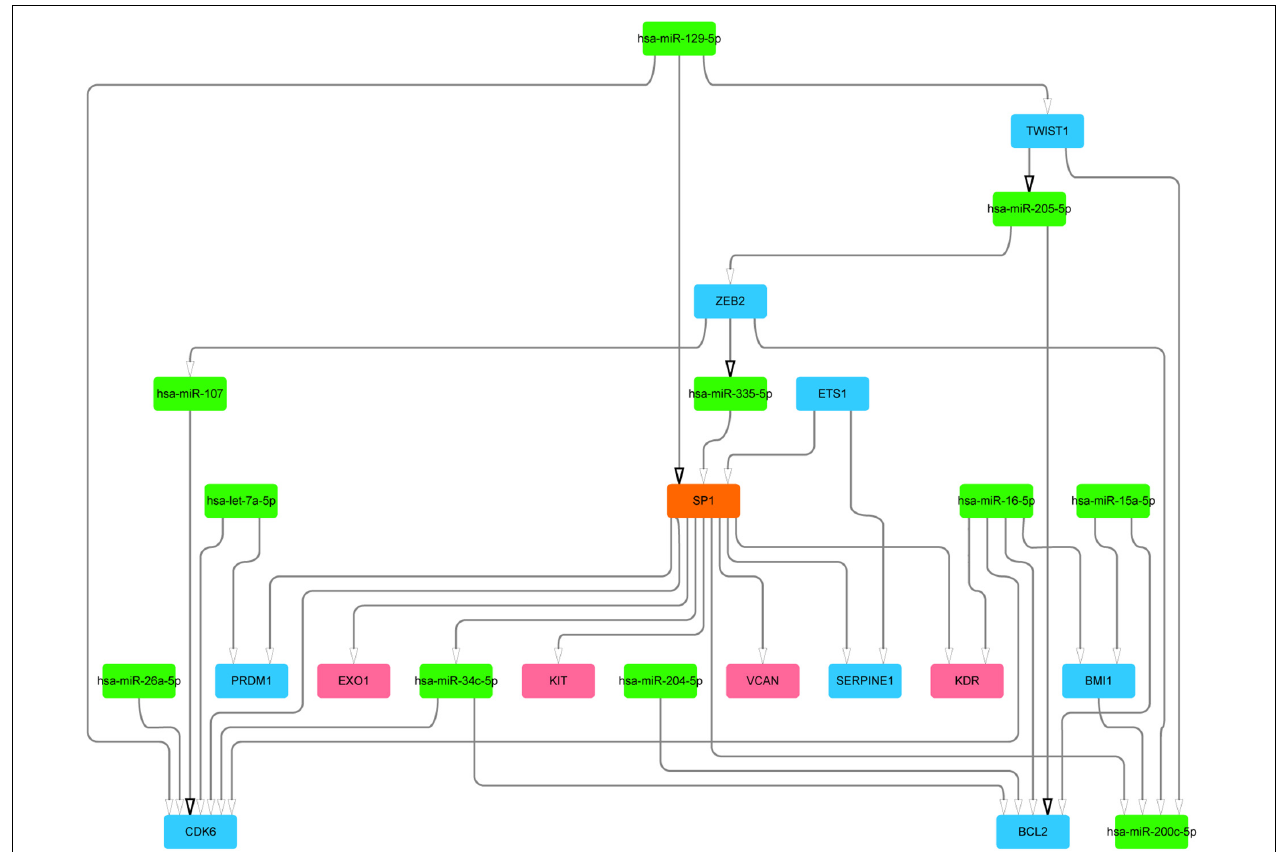
FIGURE 3 | The core regulatory module and key regulators. Blue color represents DEGs, green color represents DE-miRs, and red color represents different mutation genes. DEGs, differentially expressed genes; DE-miRs, differentially expressed microRNAs.